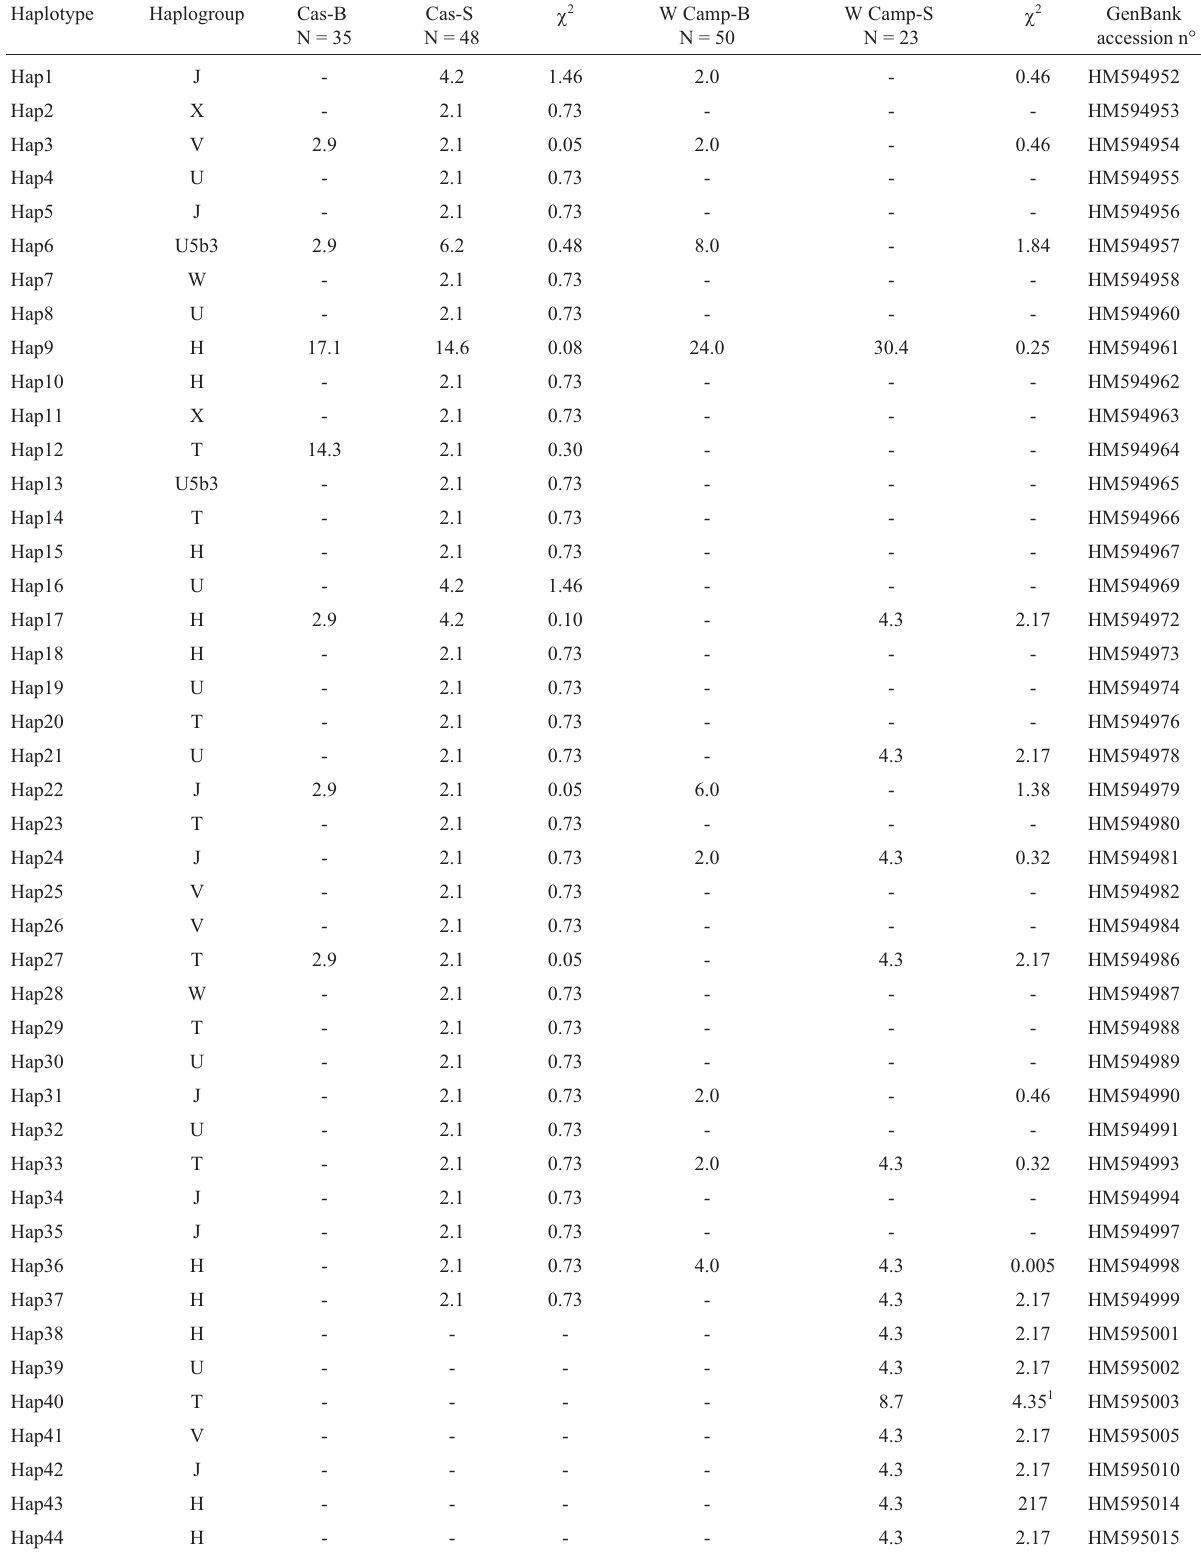
Table 4 - MtDNA haplotype distribution obtained using the two sampling methods (values are expressed as relative distribution frequencies). N: number of individuals; Cas: Cabras; W Camp: western Campidano; B: MBU method; S: STD method; (cid:2) 2 : values of Pearson chi-square (significance level with p values (cid:4)